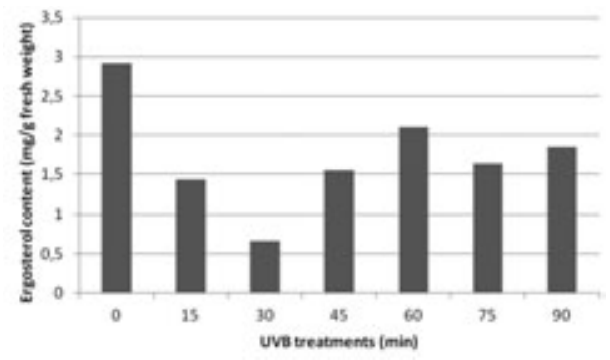
Fig. 3. Changes in ergosterol content in oyster mushrooms after 0 to 90 minutes of UVB treatments